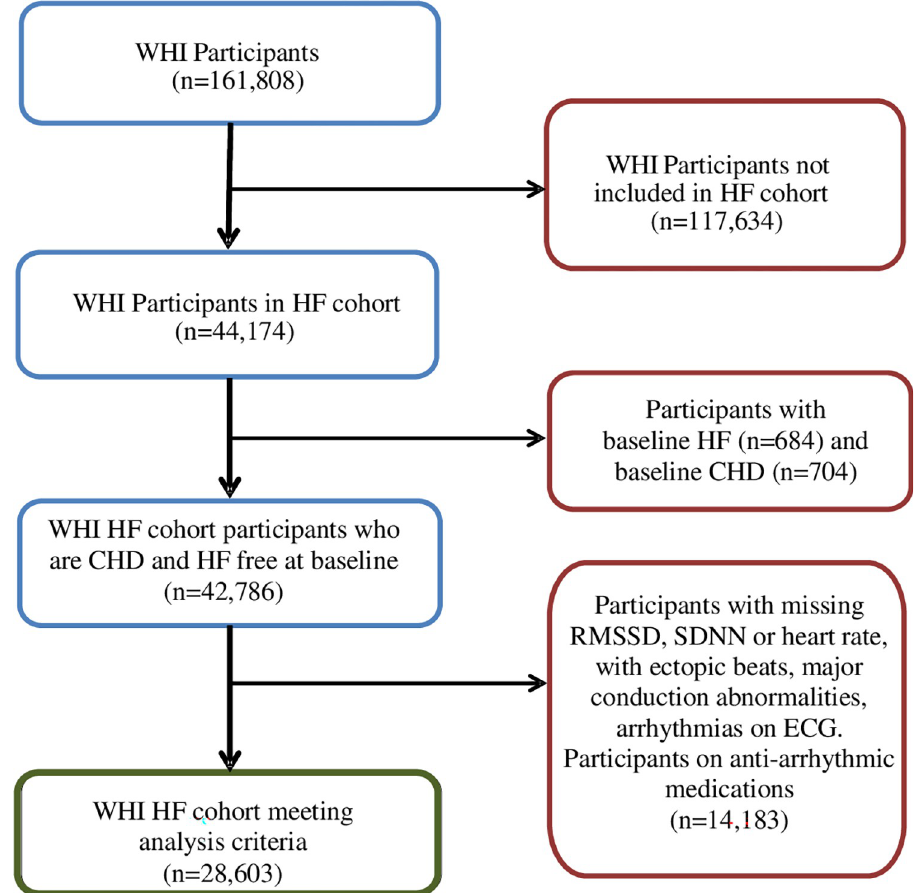
Fig 1. Flow diagram of WHI participants in the analysis. CHD: coronary heart disease; HF: heart failure; SDNN: standard deviation of normal-to-normal RR interval; RMSSD: root mean square of successive difference of RR intervals; WHI: Women Health